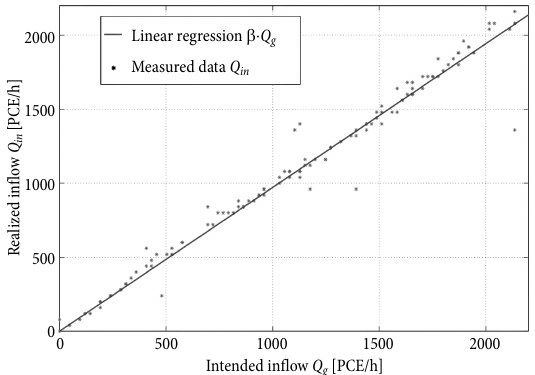
Fig. 4. Linear regression for parameter